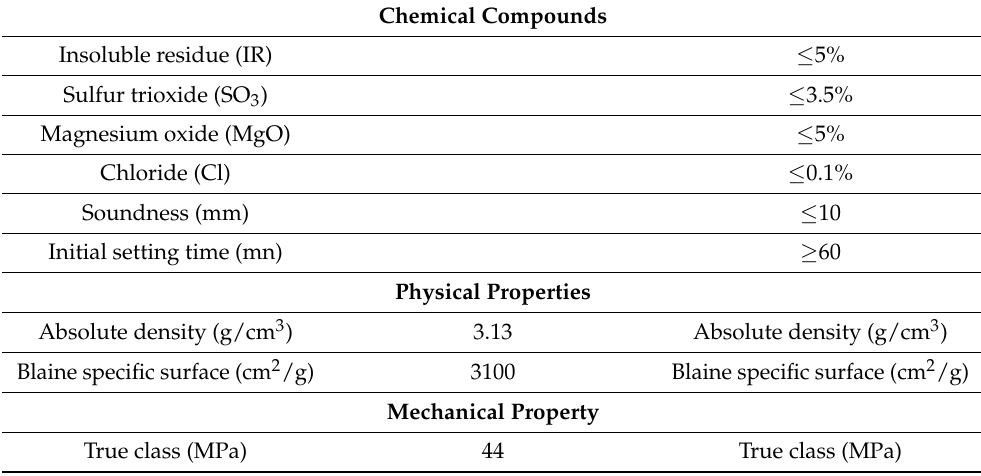
Table 1. Chemical, physical and mechanical properties of cement.